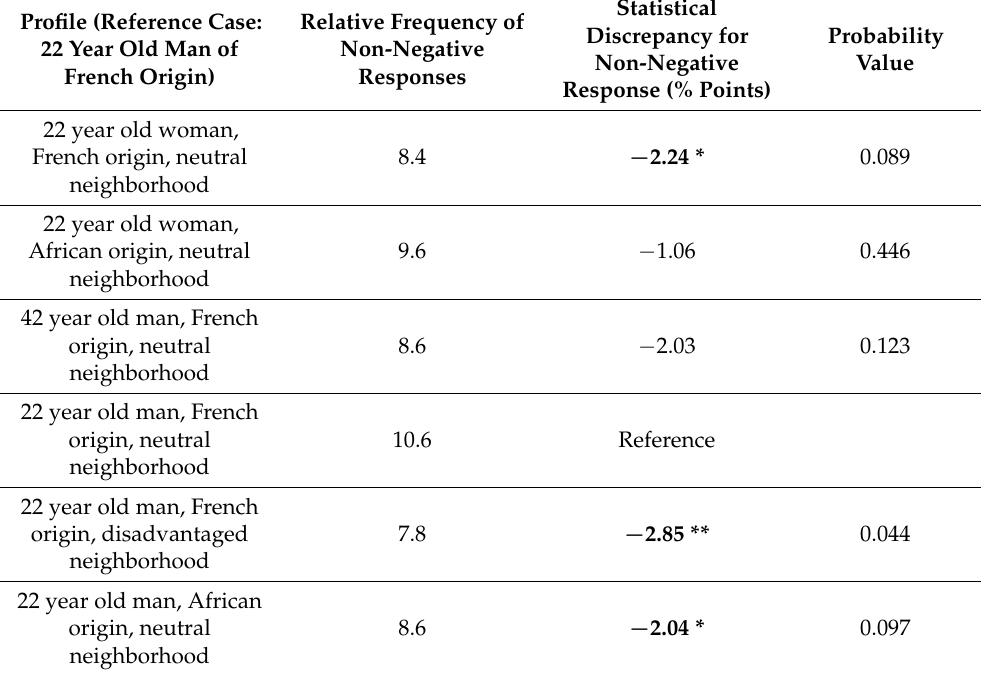
Table 3. Differences in the non-negative response rate emanating from the same used car for sale advertisements (estimated discrimination parameters) (reference profile: 22 year old man, French